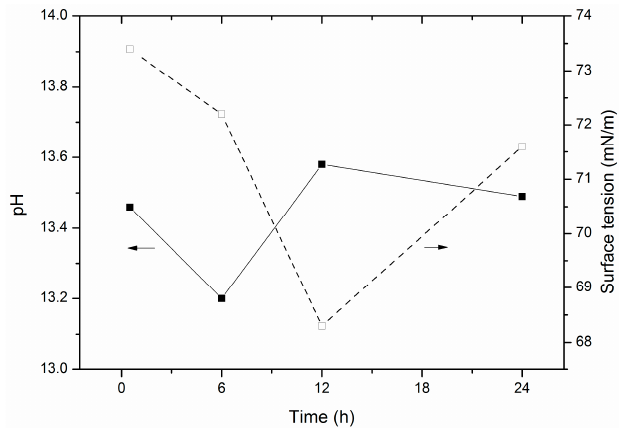
Figure 8. The surface tension and pH of cement-glass powder solution.